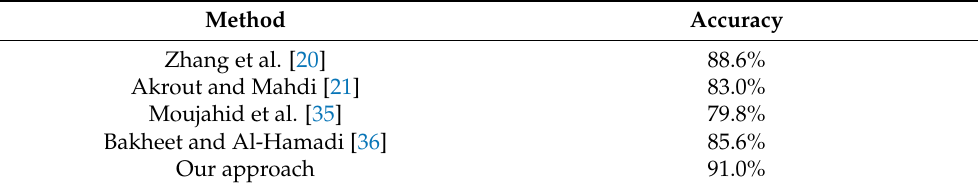
Table 4. Comparison of our approach with the previous